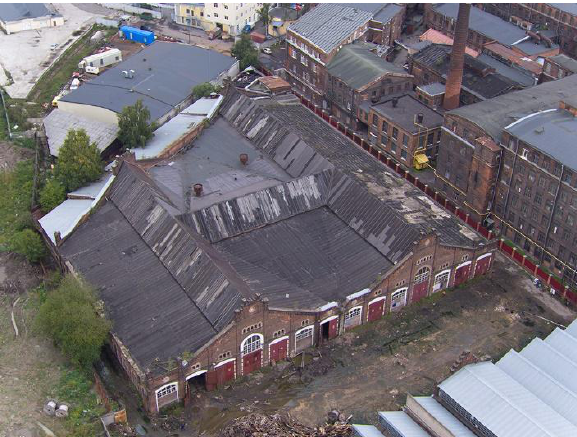
Figure 2. Aerial view of Metalworker’s Shop